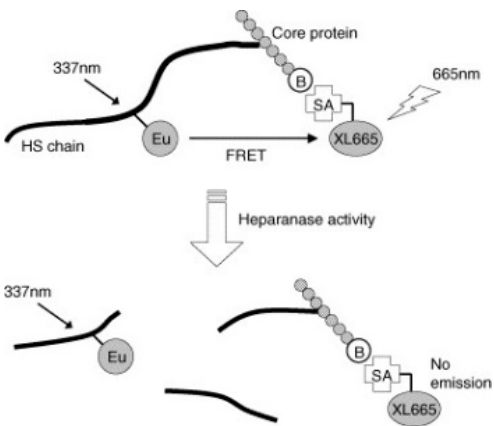
Figure 2. Heparanase assay using HTRF ® . HSPG labelled with Eu-cryptate and biotin is detected by measuring time-resolved fluorescence after the addition of XL665-labeled streptavidin (XL665-SA). Degradation of substrate by heparanase decreases the HTRF signal. B, biotin; SA, streptavidin; FRET, fluorescence resonance energy transfer. Reproduced with permission [38].